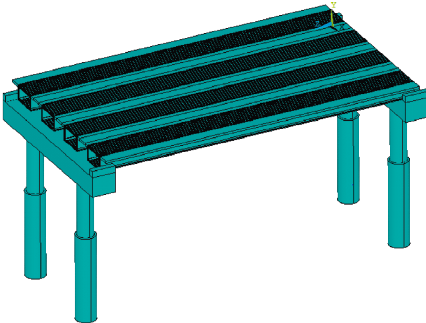
Figure 4: Finite element model for a hollow